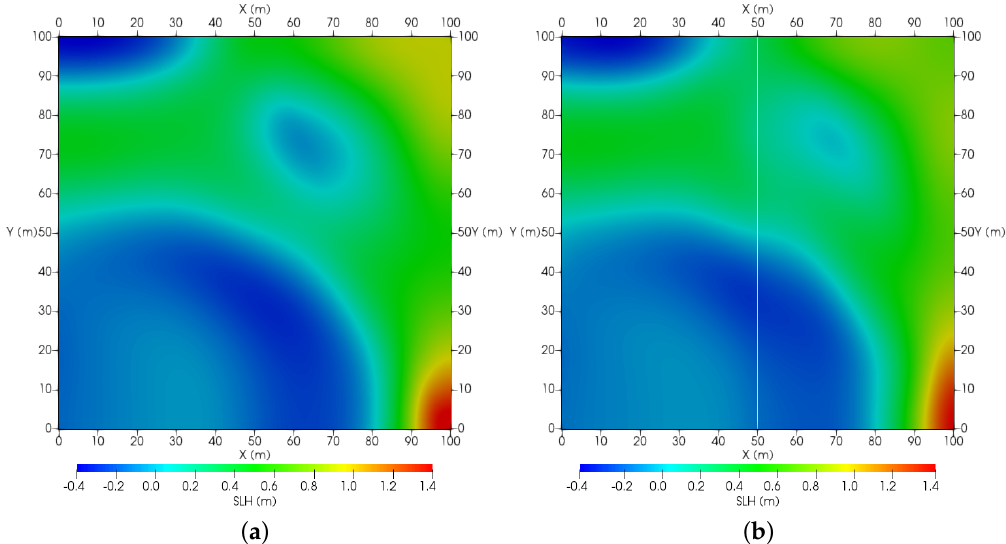
Figure 2. Sea level function (m) at t = 5 s after the preliminary simulation: ( a ) Part of the preliminary calculation. ( b ) Simulation with domain decomposition and data assimilation (DA) methods.